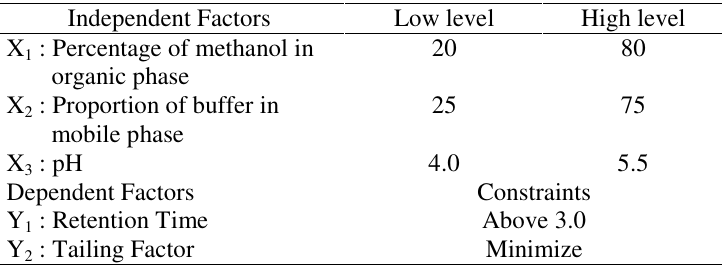
Table 1 . Factors and their corresponding levels as per 2 3 factorial design.